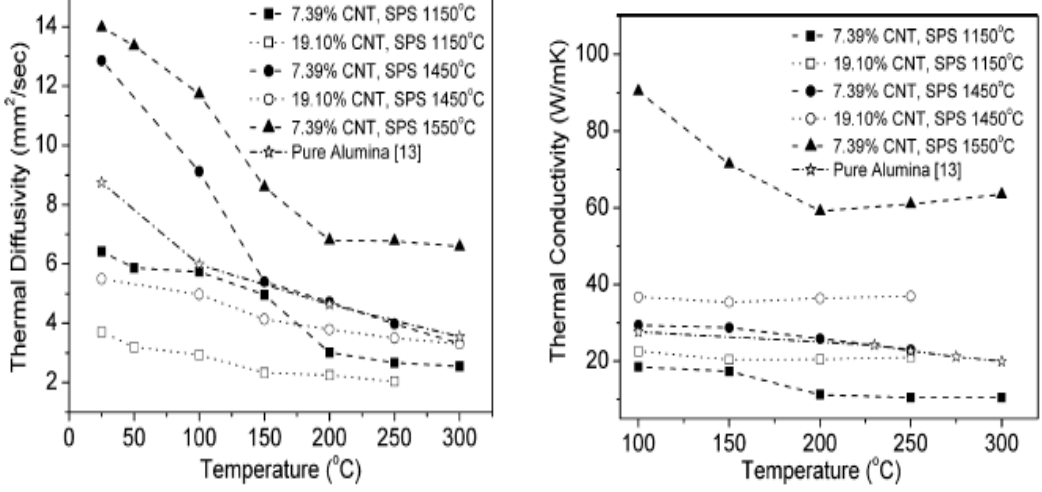
Figure 11. ( a ) Temperature dependence on thermal diffusivity; ( b ) variations of thermal conductivity with measurement temperature for Al 2 O 3 /CNT nanocomposites. Reproduced with permission from [112]. Copyright Elsevier, 2008.